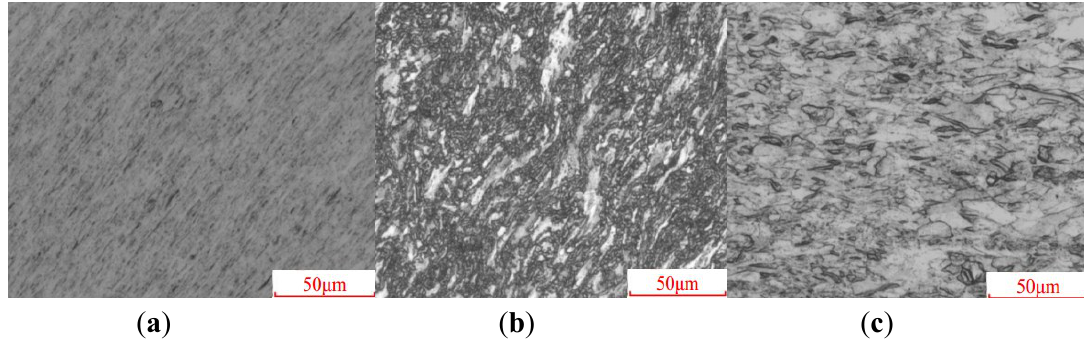
Figure 3. OM micrographs of the Cu-0.2wt%Mg alloy after ECAP at 673 K for ( a ) 1 pass, ( b ) 4 passes and ( c ) 16 passes.